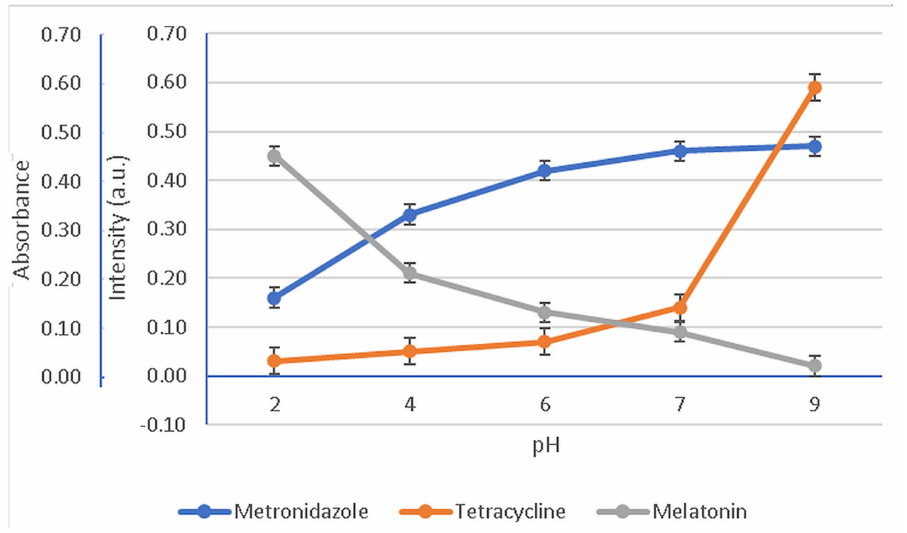
Figure 7. Variation in the normalized absorbance and fluorescence intensities as a function of pH values. Fluorescence readings for MEL at 570 nm ( λ ex = 278 nm) and T at 530 nm ( λ ex = 335 nm); absorbance readings for MZ at 320